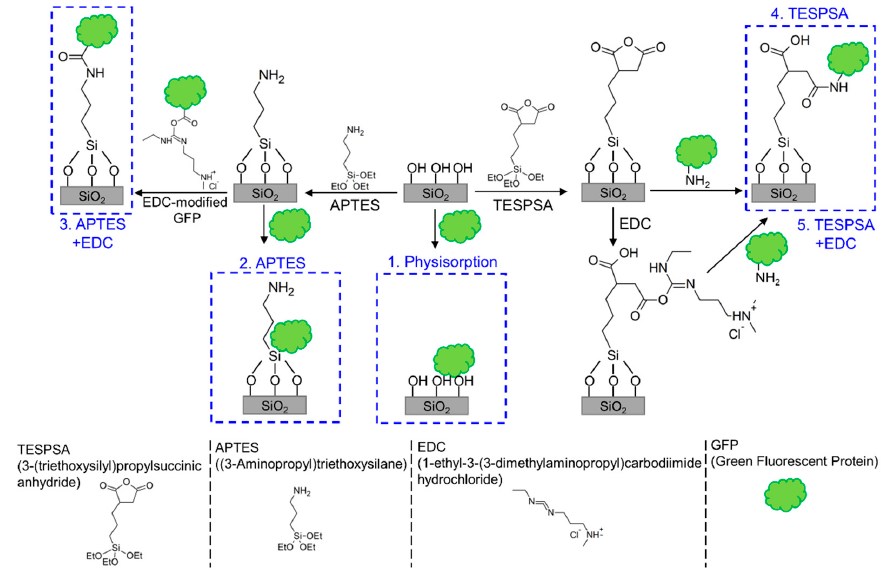
Figure 2. Different methods of surface functionalization for protein receptor immobilization verified in this work.